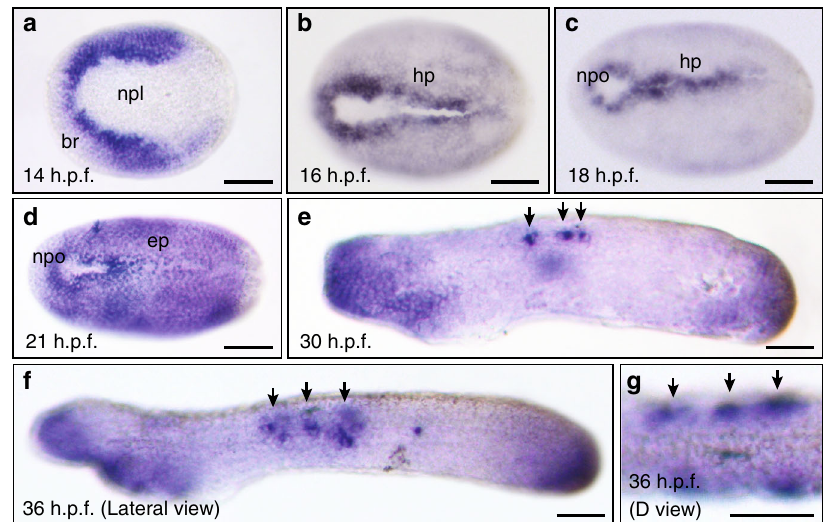
Fig. 3 Esrp is expressed dynamically in the non-neural ectoderm during amphioxus embryo development. WMISH of Esrp in Branchiostoma lanceolatum embryos. Anterior is to the left in all cases. a 14 h.p.f. early neurula (dorsal view) showing expression in the ectodermal cells located in the border region (br) next to the neural plate (npl). b , c 16 h.p.f. and 18 h.p.f. mid-neurula embryos (dorsal view) stained most strongly in the ectodermal cells next to the neural plate border and that form the hinge points (hp) during neural tube closure. The location of the neuropore (npo) is indicated. d In 21 h.p.f. late neurula (dorsal view), Esrp expression is extended throughout the whole epidermis (ep). e , f Early (30 h.p.f.) and late (36 h.p.f.) pre-mouth stages (lateral views) showing Esrp -positive cells in anterior ectoderm, tailbud epithelia and in a few cells that likely corresponding to migrating sensory cells during epidermal incorporation or already integrated into the epithelium (black arrows). g Dorsal view of a 36 h.p.f. embryo shows the epidermal location those Esrp -positive cells (black arrows). Scale bars: 50 µ m a – f , 25 µ m